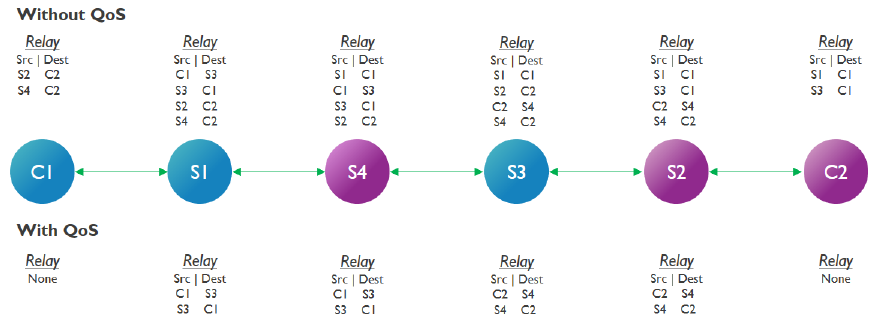
Figure 11. Customized relay feature for